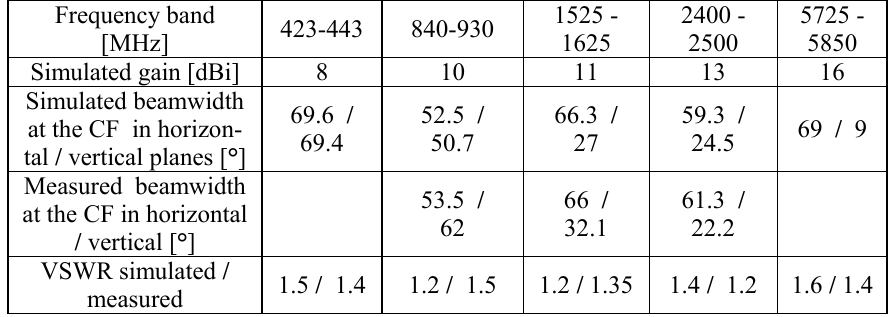
Table 1. The simulated and measured results of the developed antenna array